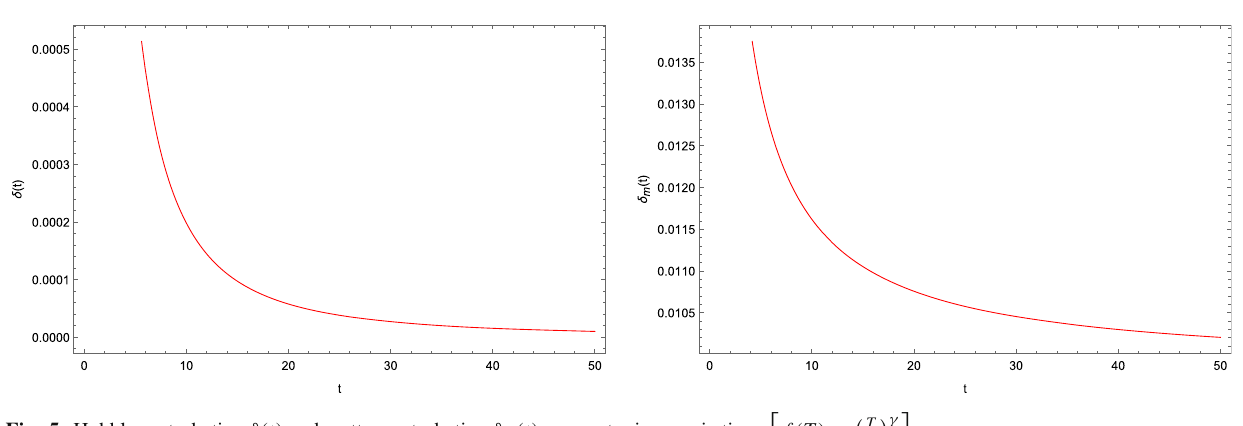
Fig. 5 Hubble perturbation δ( t ) and matter perturbation δ m ( t ) parameter in cosmic time,